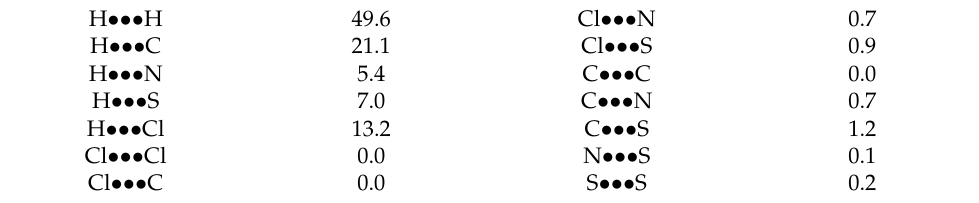
Figure 2. Hirshfeld surface (plotted over d norm ) and 2D fingerprint plot of L2. Table 2. Percentage distribution (%) of the intermolecular contacts in the structure of ligand L2.